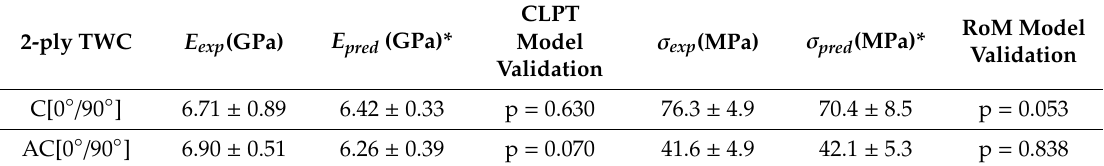
Table 4. Predicted elastic modulus and experimental mechanical response for 2-Ply TWC